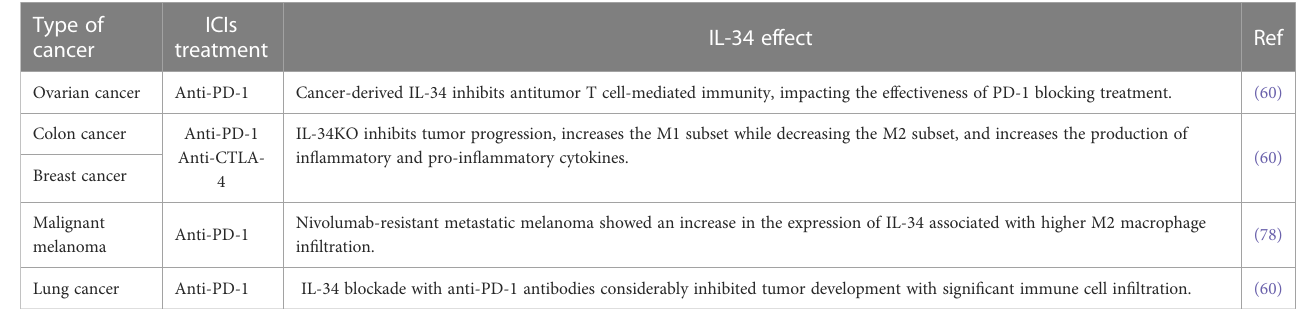
TABLE 1 The effect of IL-34 on cancer-related